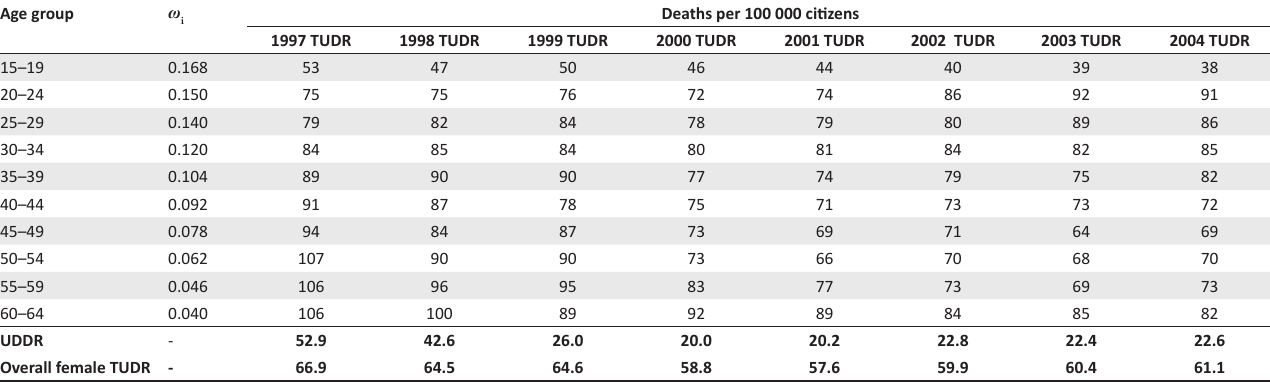
TABLE 2: The female TUDR values reported between 1997 and 2004. Age group ω